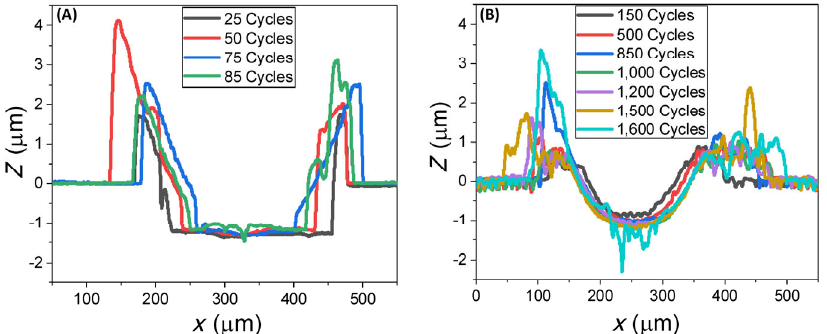
Fig. 15 Surface topography profile of the wear tracks on the PDA/PTFE coatings on (A) smooth and (B) laser textured stainless steel from progressive tests in Figs. 14 and